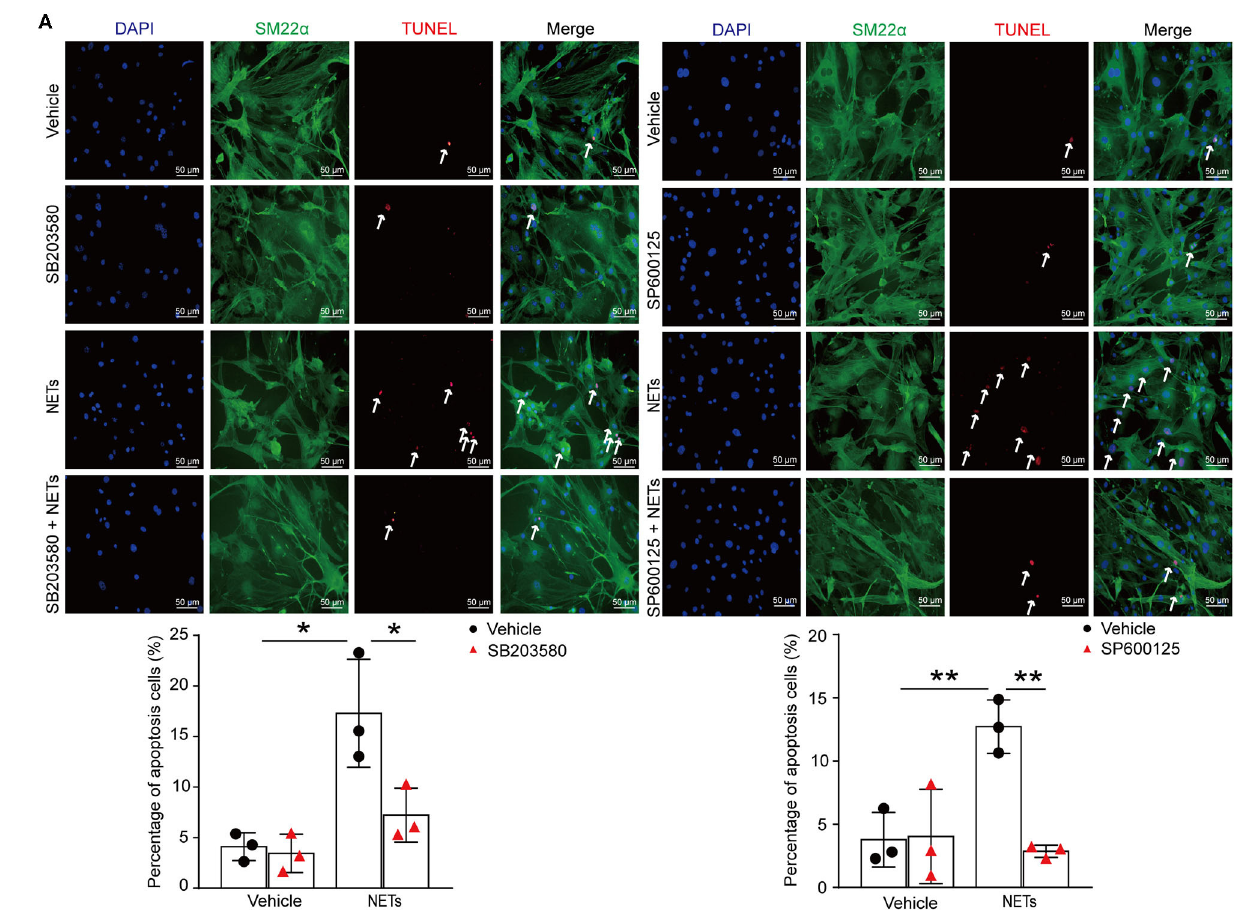
FIGURE 7 | Inhibition p38/JNK pathway suppressed NETs induced VSMC apoptosis. Primary VSMCs isolated from aortas of ApoE − / − mice were preincubated with p38 inhibitor SB203580 or JNK inhibitor SP600125 for 30min before NET treatment for 24h. (A) TUNEL staining for apoptosis cells (red) and the percentage of apoptosis cells were analyzed. VSMCs were stained with SM22 α . Nuclei were stained with DAPI. n = 3 per group, * p < 0.05, ** p < 0.01. Statistical significance was determined by one-way ANOVA test followed by the unpaired t